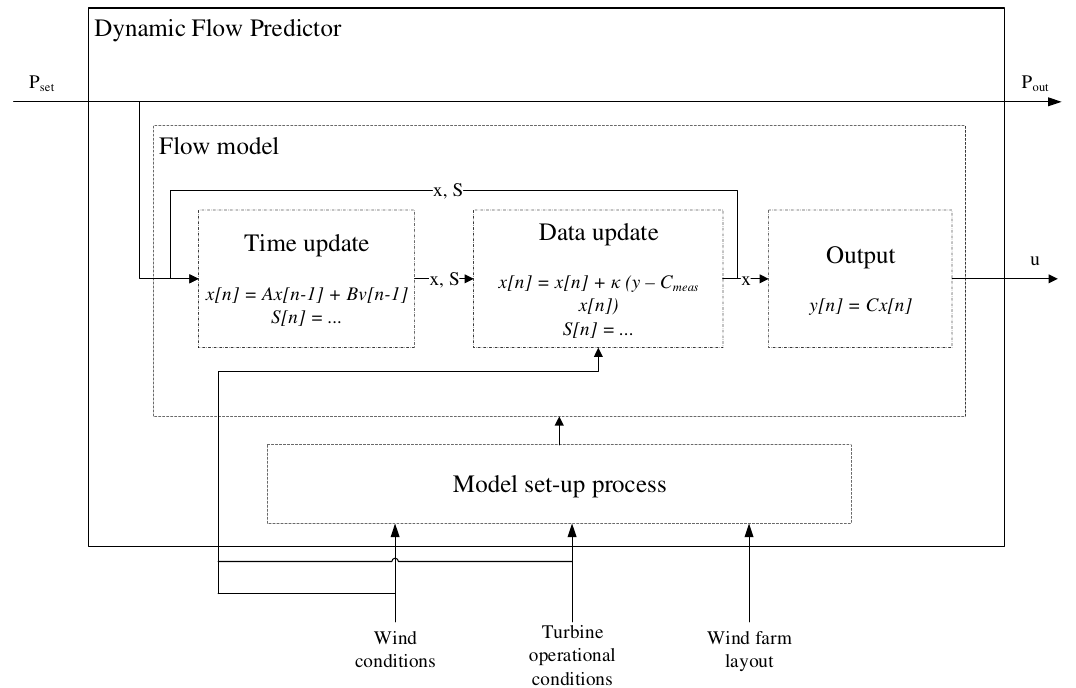
Figure 1. System structure of a dynamic flow predictor (DFP), showing the system update process and Kalman filter time update and data